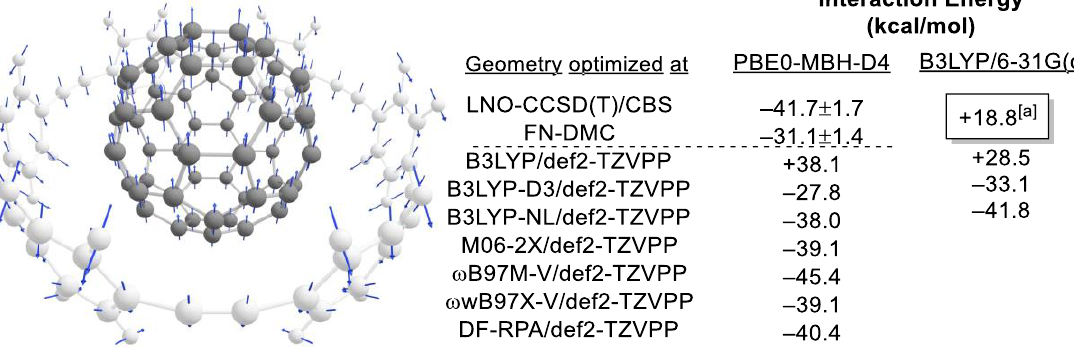
Figure 3. All values are in kcal/mol. LNO-CCSD(T) and FN-DMC values are taken from ref [72]. Values below the dotted line are calculated with ORCA 5.0.3 [67] using the following keywords: “DFA/def2 -TZVPP aut oaux verytightscf rijcosx” with the geometry supplied by ref [72]. DF-RPA is calculated with MRCC [68]. Blue arrows are the displacement vectors of the imaginary frequency at B3LYP/6-31G(d). [a] Interaction energy at the same level of theory as the geometry optimization, i.e., at B3LYP/6-31G(d).